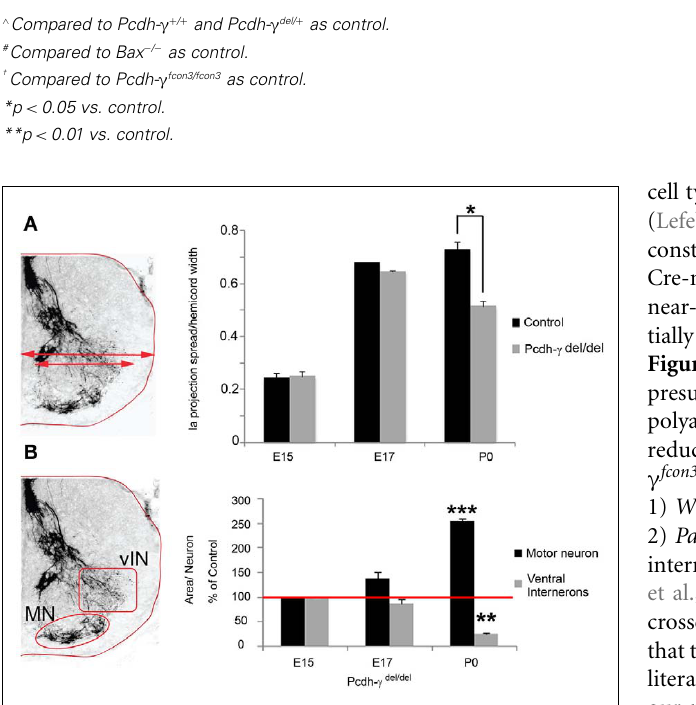
Compared to Pcdh- γ fcon3/fcon3 as control.